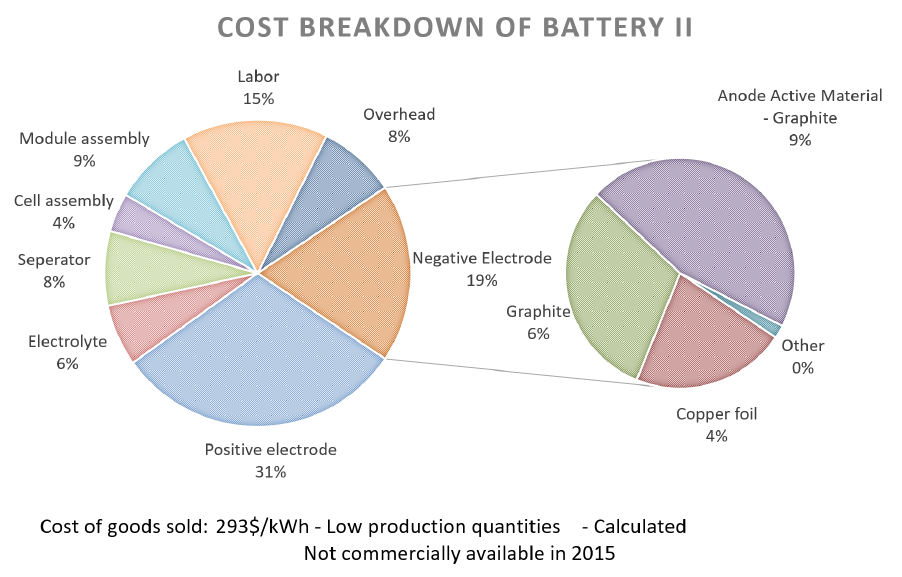
Figure 8. Cost breakdown of battery II with a special focus on the anode composition.